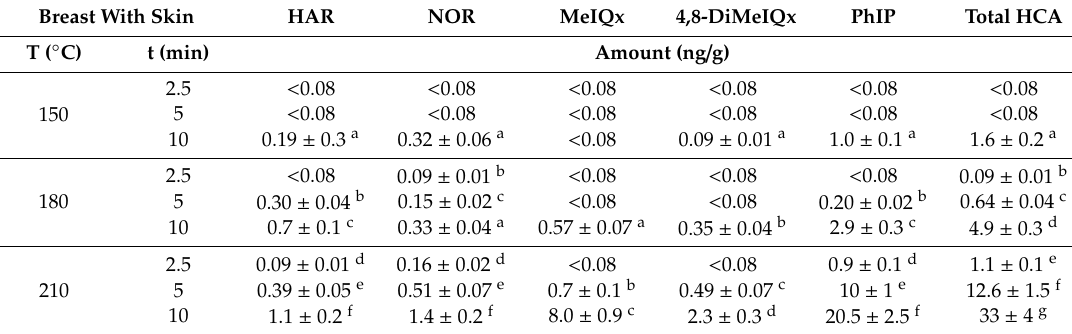
Table 3. Heterocyclic amine (HCA) content of heat-treated chicken breast with skin. Breast With Skin HAR